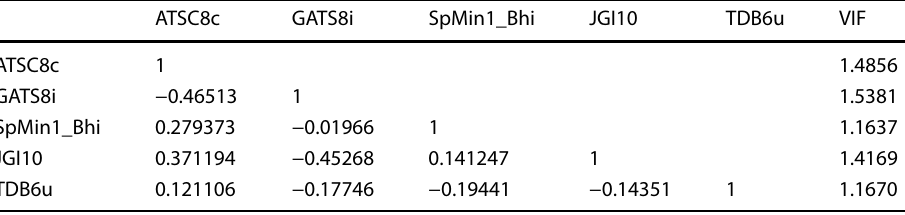
Table 4 Correlation matrix of the model descriptors